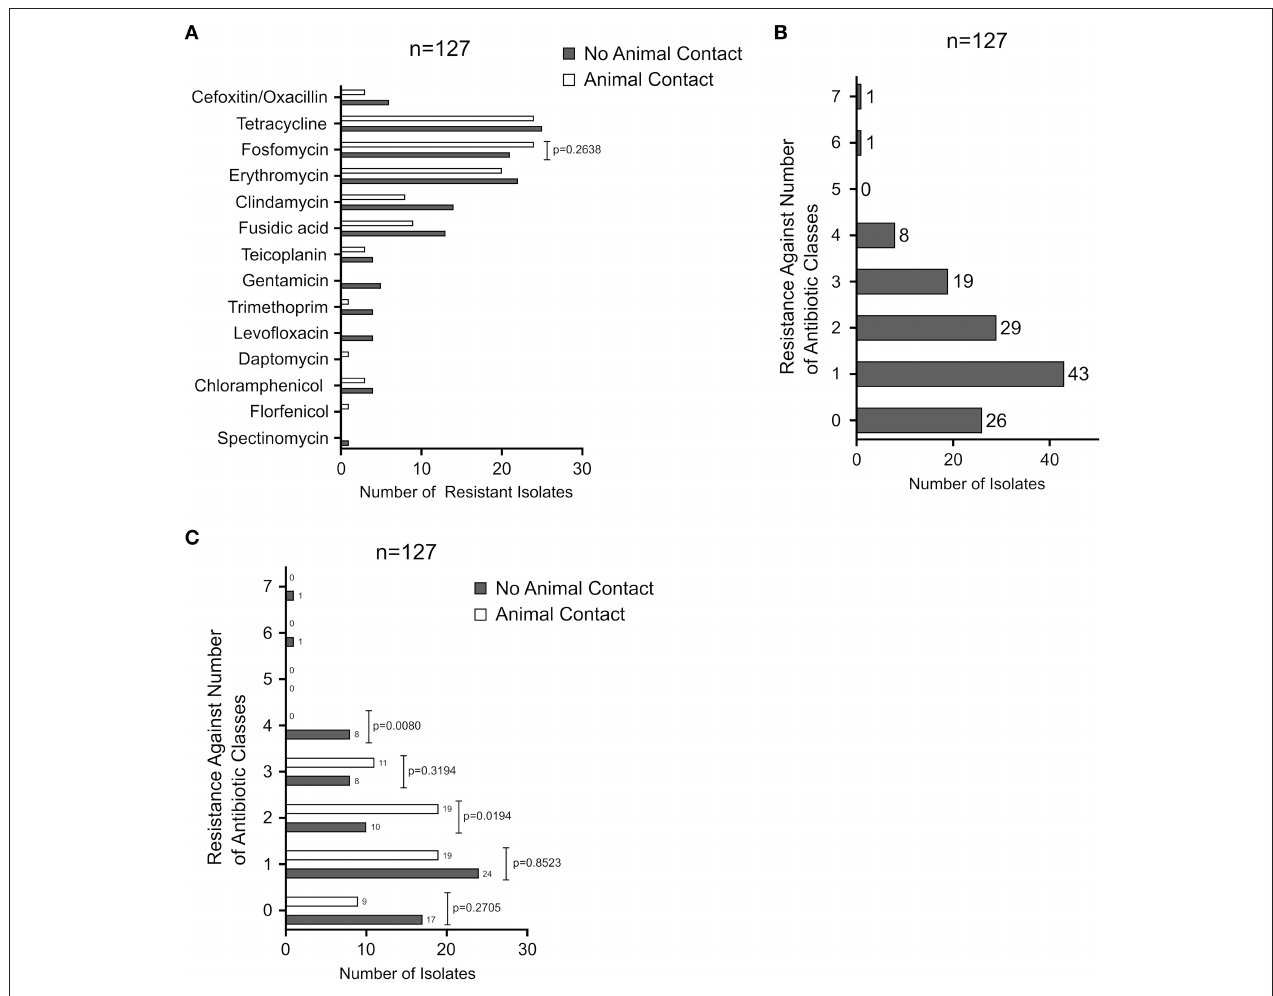
FIGURE 3 | (A) Comparison of the number of resistant isolates arising from nasal swabs of individuals with animal contact (white bars) or without animal contact (gray bars). (B) Analysis of multidrug-resistant isolates. The number of resistant isolates is plotted against the simultaneous resistance toward 0–7 antibiotic classes. (C) Comparison of the number of multidrug-resistant isolates arising from nasal swabs of individuals with animal contact (white bars) or without animal contact (gray bars). Contingency analysis in (A,B) was performed using Fisher’s Exact Test by employing the GraphPad Prism software